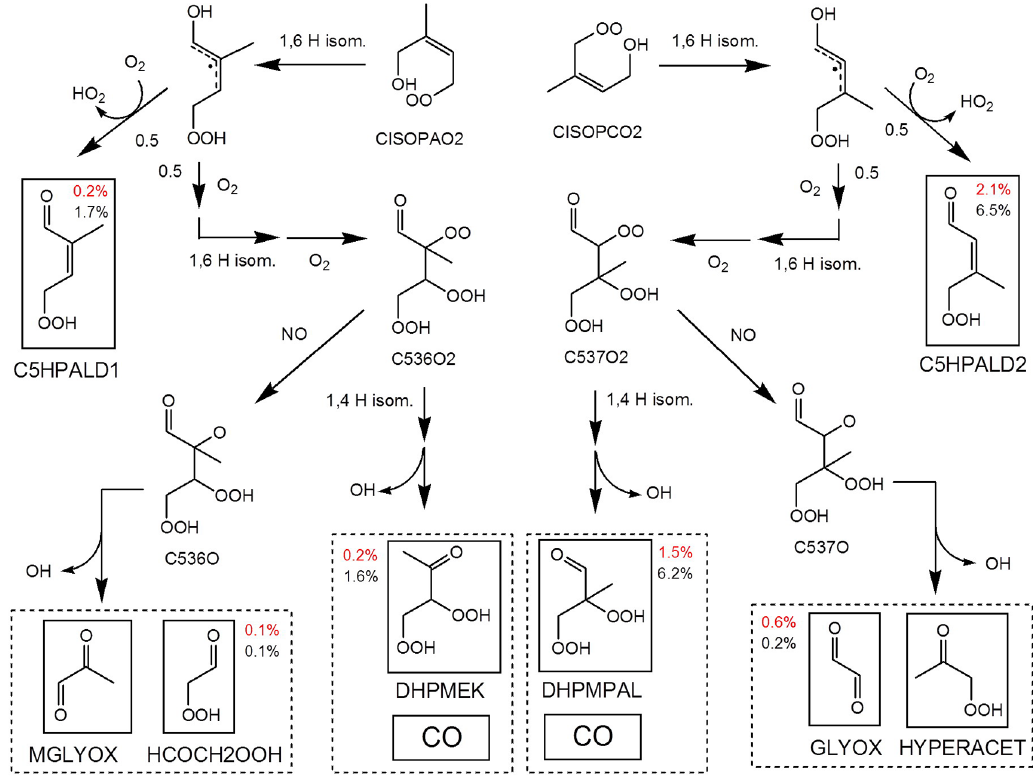
Figure 3. Schematic of the mechanisms following the 1,6 H atom shift isomerisation reactions of CISOPAO2 and CISOPCO2, as represented in MCM v3.3.1 (see also Fig. 2). As in Fig. 2, propagating channels of the reactions of NO with the intermediate peroxy radicals (C536O2 and C537O2), and competing unimolecular isomerisation reactions, are shown. Species in solid boxes are the resultant first-generation oxygenated end products, with their associated molar yields at 1ppb NO (in red) and 100ppt NO (in black) at 298K (see text and Fig. 4 for further details). Note that GLYOX and MGLYOX are also formed via alternative routes, shown in Fig.